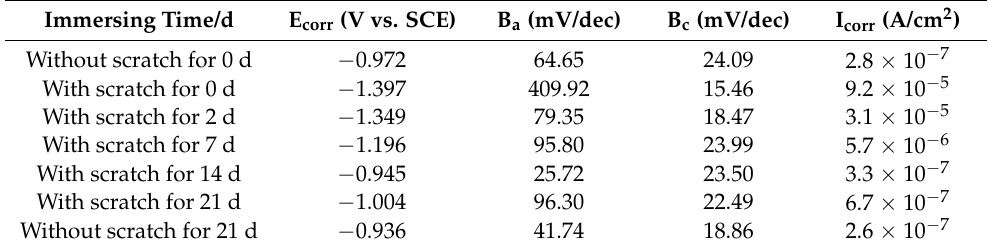
Table 4. Polarization parameter of MLDHs with or without a scratch after immersing for different immersion times.